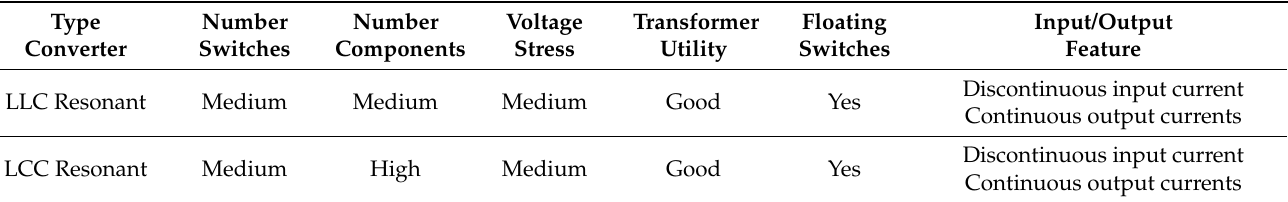
Table 4. Comparative summary of SIMO Isolated DC–DC Resonant